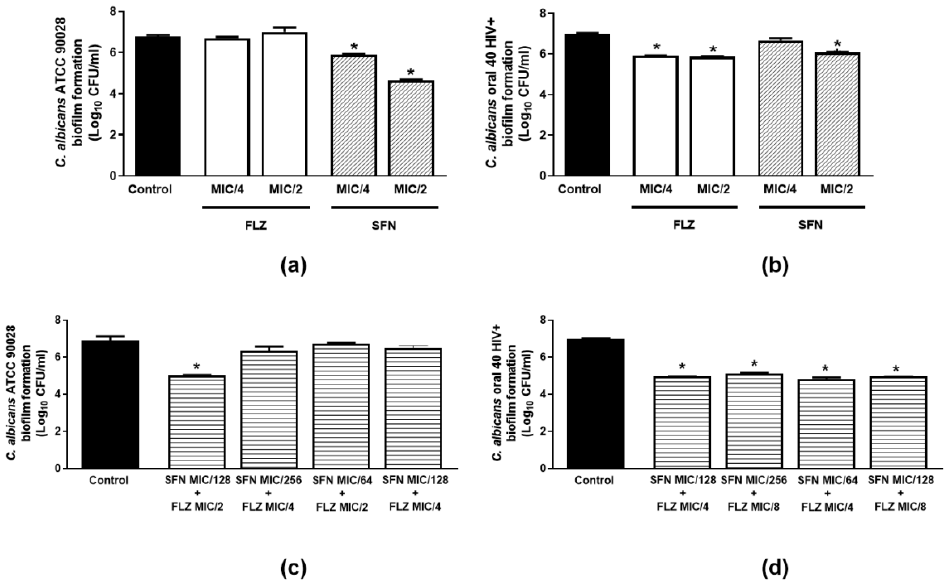
Figure 3. Effects of sulforaphane (SFN) and fluconazole (FLZ) on biofilm formation by C. albicans spp. SFN and FLZ were tested at MIC/2 and MIC/4 against ( a ) C. albicans ATCC 90028 and ( b ) C. albicans clinical isolate (Oral 40 HIV + ). The combined effects of SFN (MIC/64 to MIC/256) with FLZ (MIC/2-MIC/8) against ( c ) C. albicans ATCC 90028 and ( d ) C. albicans clinical isolate (Oral 40 HIV+) were investigated over 24 h. The control consisted of inoculum plus culture medium. Data were obtained from three independent experiments and are expressed as Log 10 CFU/mL.* p < 0.05 differs from the control group.